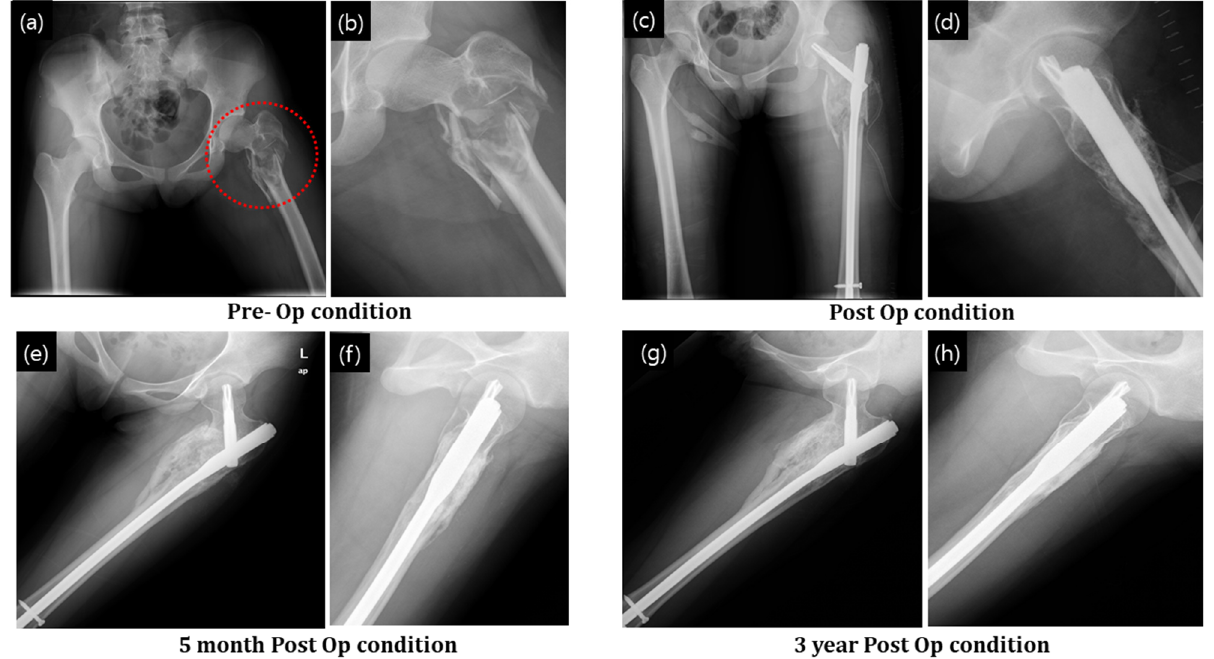
Figure 7. Fracture of intertrochanter region of the femur after a cyst formation was treated with granular bone substitute. ( a , b ) X-ray of the bone fracture, ( c , d ) postop condition with application of granular bone substitute and support implant, ( e , f ) after 5 months of operation and ( g , h ) after 3 years of operation. Red circle indicate defect zone with fracture.